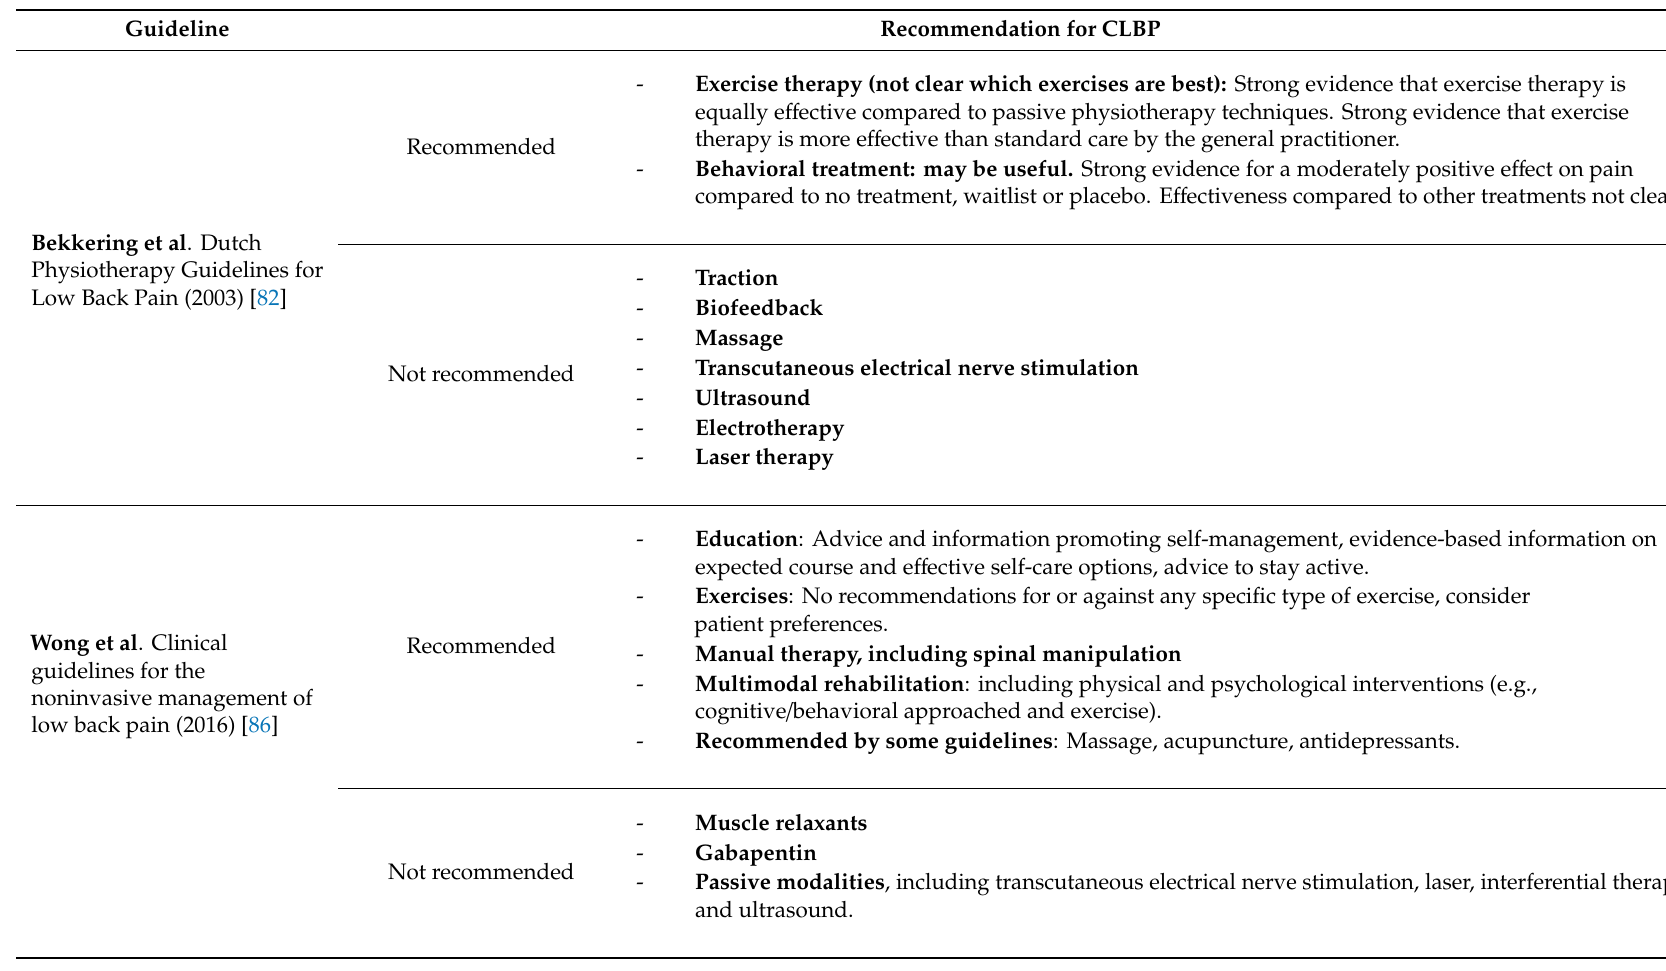
Table 2. Overview of recommendations in (clinical) guidelines for chronic low back pain